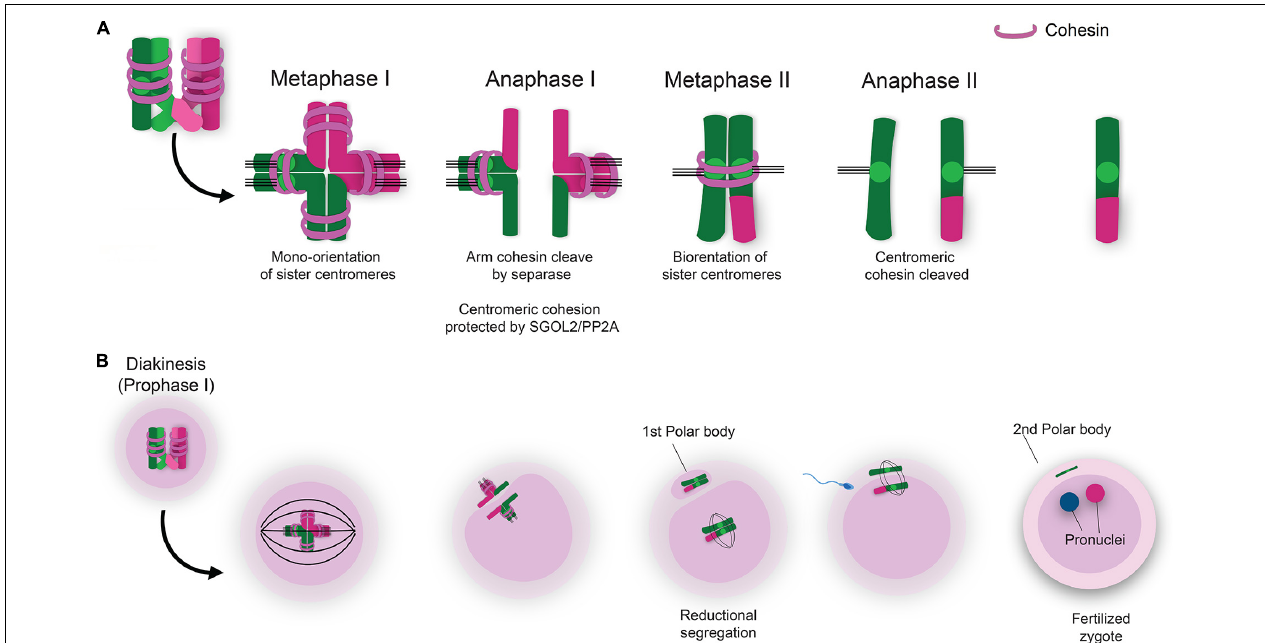
FIGURE 3 | Sequential removal of cohesin ensures proper chromosome segregation and completion of meiosis. (A) Removal of cohesin rings from the chromosome arms during MI permits segregation of homologous chromosomes during anaphase I. Cleavage of centromeric cohesin during MII allows for segregation of sister chromatids and formation of haploid gametes. (B) The LH surge induces the transition of the oocyte from meiotic prophase I to complete the first meiotic division of homologous chromosomes resulting the extrusion of the first polar body and arrest at metaphase II. Fertilization is the subsequent trigger for the second meiotic division with segregation of sister chromatids and extrusion of the second polar